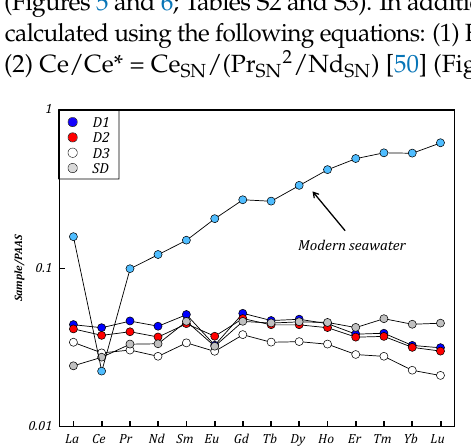
9 of 25 Figure 4. 87 Sr/ 86 Sr ratios of different types of dolomites in Xixiangchi Formation. The 87 Sr/ 86 Sr ratios of the Cambrian seawater are from [47]. 4.4. Rare Earth Elements (REEs) For comparison, the rare earth elements (REEs) concentrations of the investigated Xixiangchi dolomites are normalized by the post-Archaean Australian Shale (PAAS) [48], (Figures 5 and 6; Tables S2 and S3). In addition, the Eu and the Ce anomalies of dolomites are calculated using the following equations: (1) Eu/Eu* = (3 × Eu SN ) / (2 × Sm SN + Tb SN ) [49] and (2) Ce/Ce* = Ce SN /(Pr SN2 /Nd SN ) [50] (Figure 7; Tables 1 and S3). 4.4.1. REEs in Dolomite D1 The total REE concentrations ( Σ REE) of D1 range from 4.4 to 11.5 μ g/g, with an av-